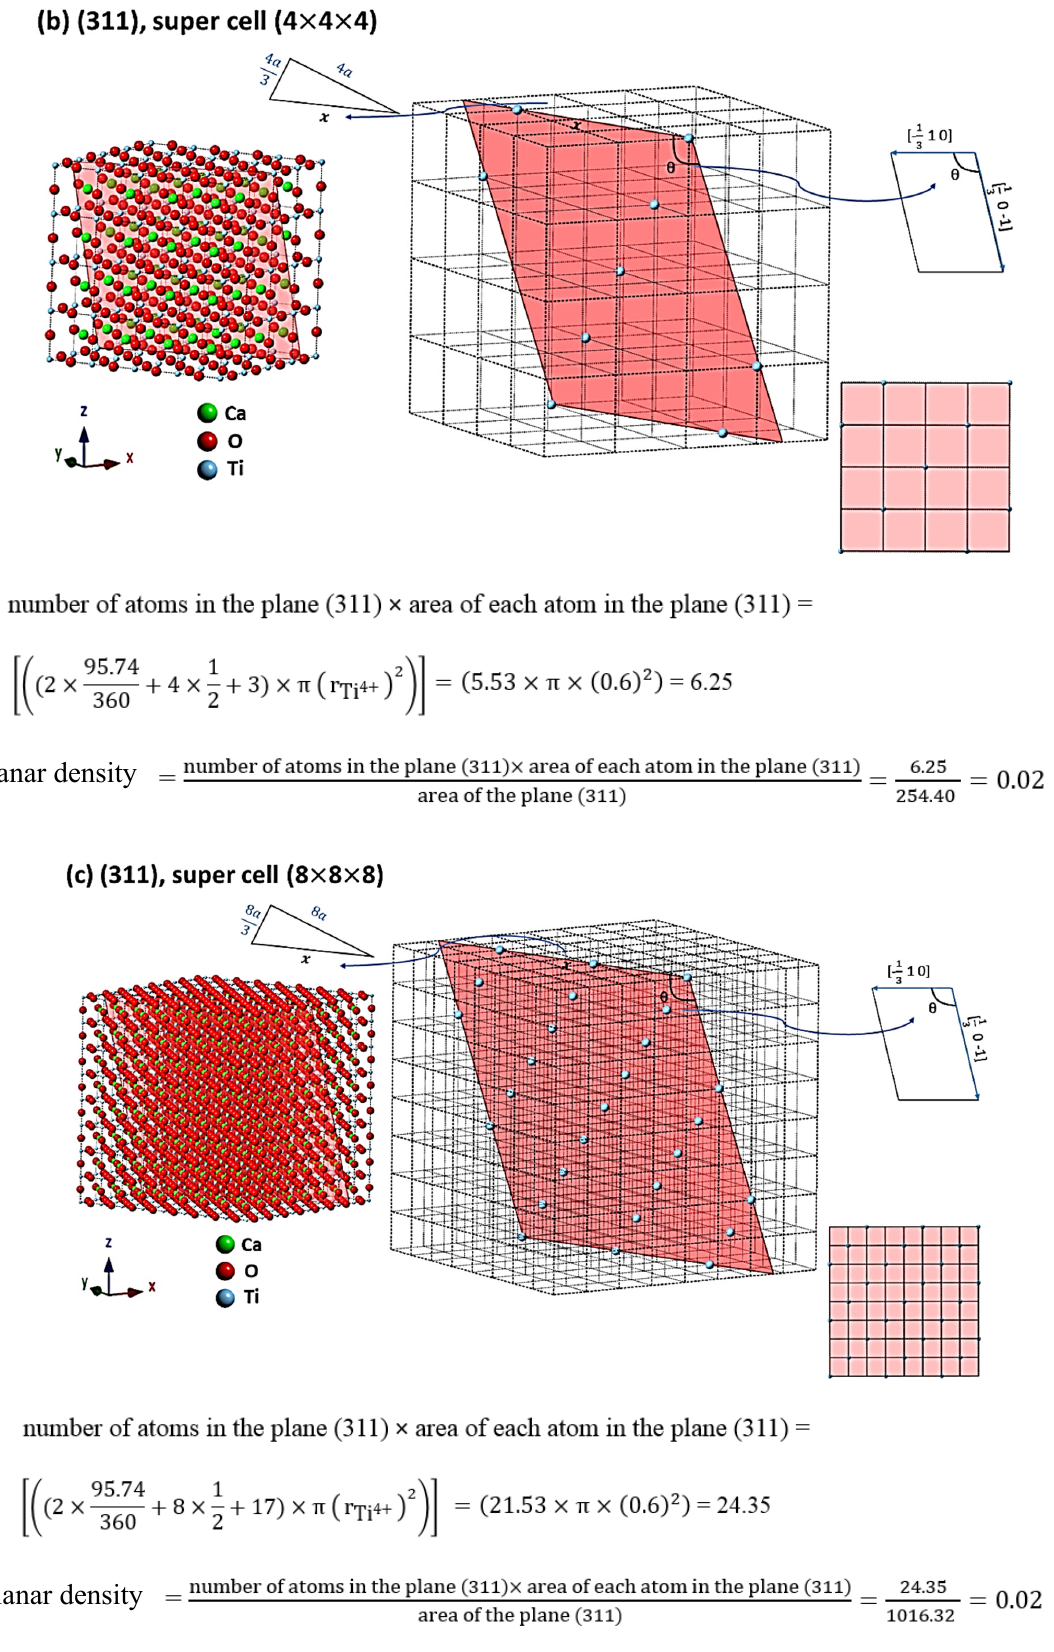
Figure 5. The concept of a symmetry cell; geometry of planes and calculations of planar density of ( a ) (311) super cell (3 × 3 × 3), ( b ) (311) super cell (4 × 4 × 4) and ( c ) (311) super cell (8 × 8 ×